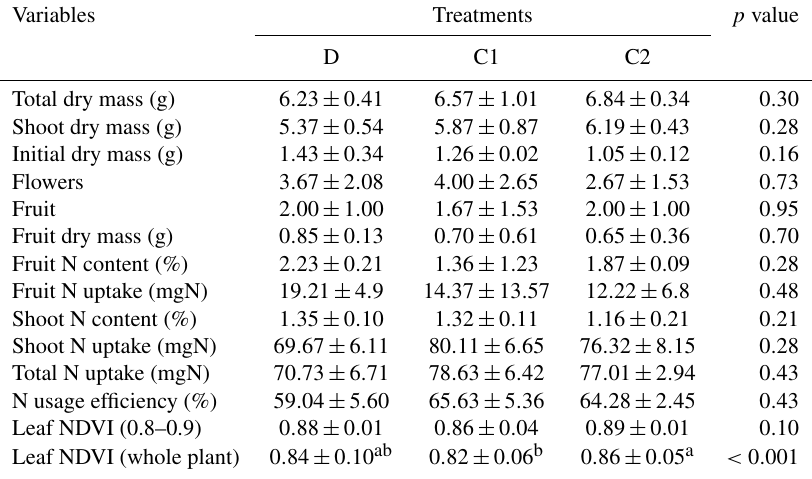
Table A1. The mean, standard deviation of physiological indicators, and the p value of Welch’s ANOVA test across treatments. Note: comparison of leaf NDVI was performed both at the third to sixth branches (equivalent to the normalized plant height of 0.8 to 0.9) and the whole-plant scale. Values with different letters indicate significant difference ( p < 0 . 05).